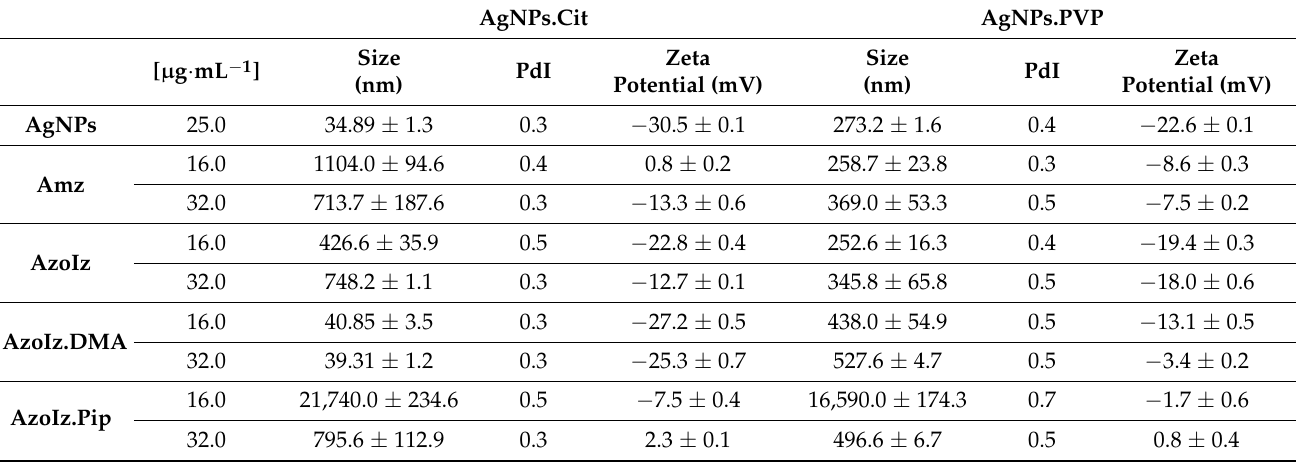
Table 1. Size, PdI, and zeta potential values of AgNPs.Cit or AgNPs.PVP alone, in a concentration of 25.0 µg·mL − 1 , and conjugated with organic molecules in two different concentrations (16 µg·mL − 1 and 32.0 µg·mL − 1 ).